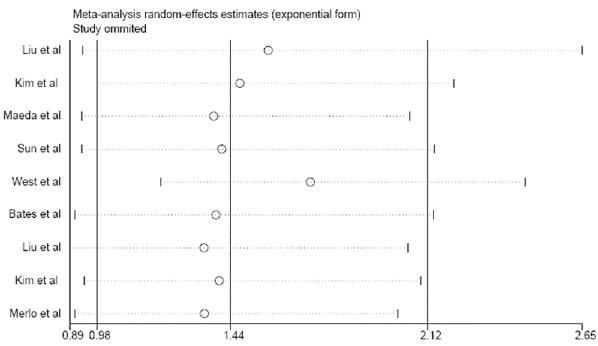
Fig 3. Sensitivity analysis of DFS in the